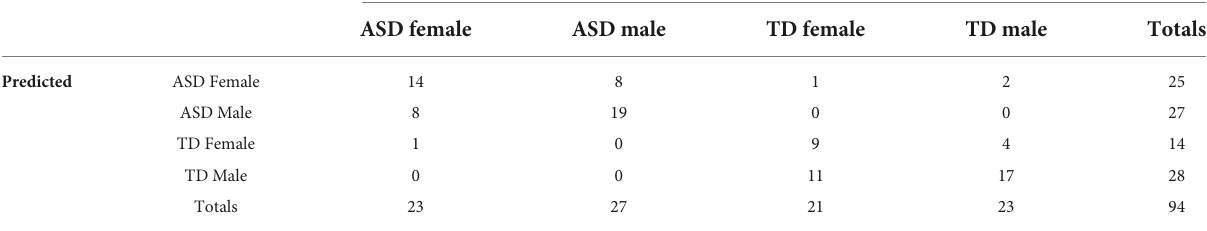
TABLE 2 Confusion matrix from the linear discriminant analysis on the test data.